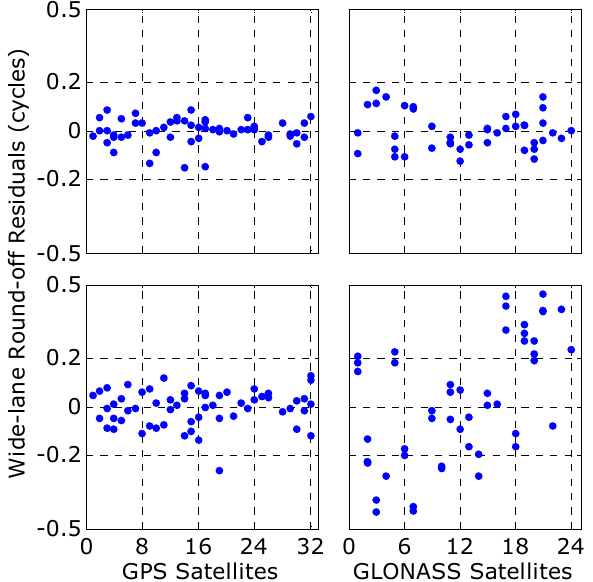
Figure 3. Round-off residuals of wide-lane single-differencing between-receivers (SDBR) ambiguities of GPS and GLONASS satellites for a baseline with homogeneous receivers ( top ) and a baseline with heterogeneous receivers ( bottom ).